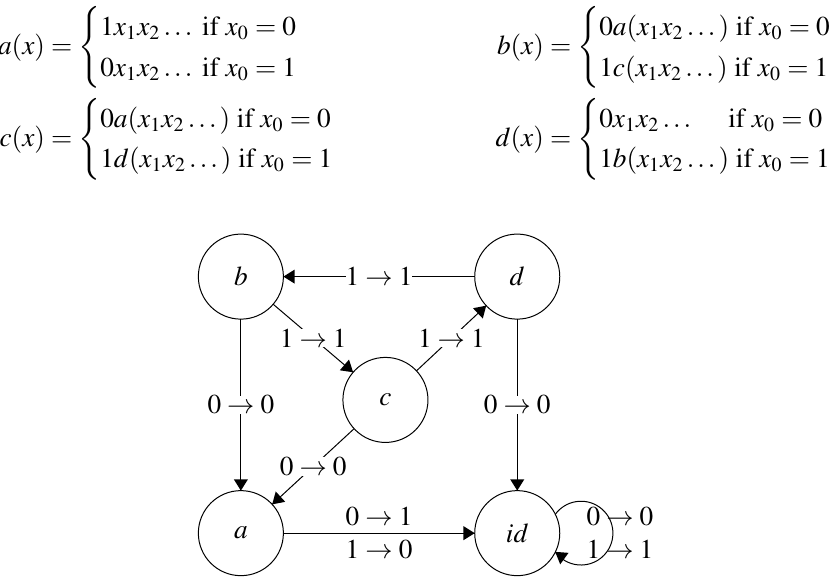
Figure 4: Mealy automaton defining the Grigorchuk